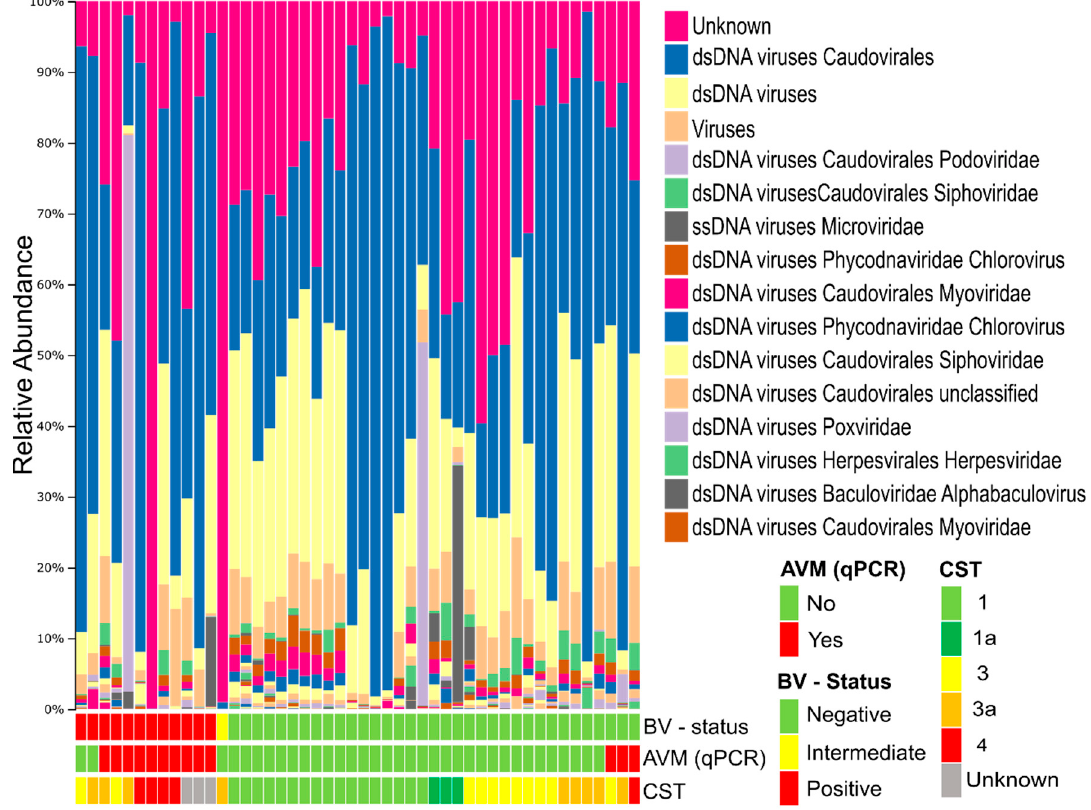
Figure 1. Composition of the vaginal virome by bacterial community status. Viral community composition by relative abundance, grouped by bacterial vaginosis (BV), abnormal vaginal microbiota (AVM), and the community state type (CST) of the sample bacterial community. Taxonomy based on viral database sequence match. Taxonomic entities are ordered top to bottom from most to least abundant.